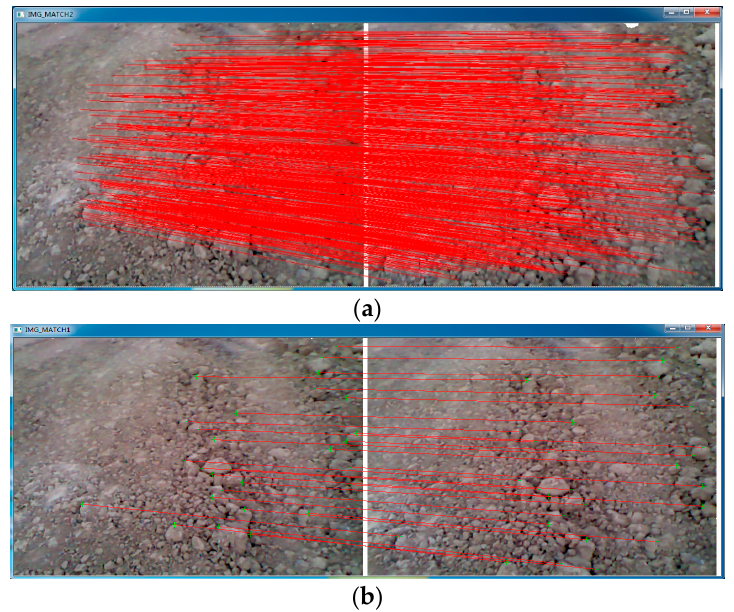
Figure 3. Features detection and matching results. ( a ) 2D feature detection and matching; ( b ) 3D feature detection and matching.